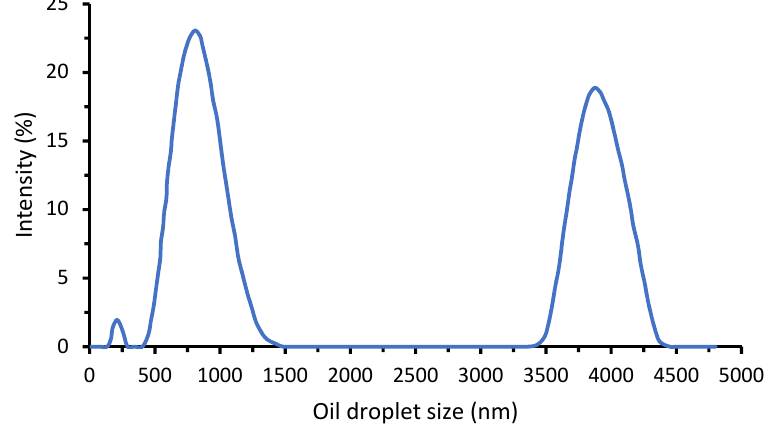
Figure 2. Size distribution of oil droplet in oil/water emulsion sample.